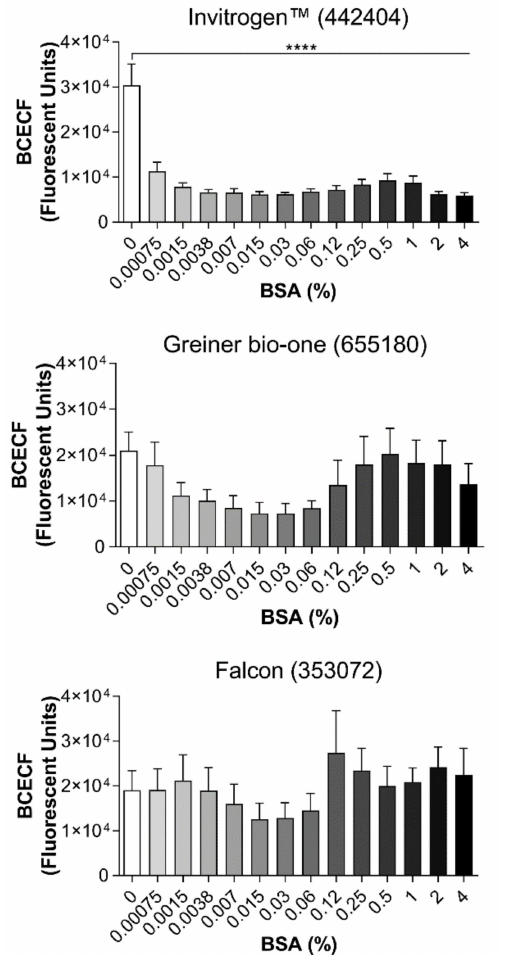
Figure 2. BSA blocking on di ff erent types of 96-well plates. BSA was used to prevent non-specific adhesion of platelets to the plastic. To find the optimum conditions, 3 types of 96-well plates (Invitrogen ™ —442404; Greiner Bio-one—655,180 and Falcon—353072) were blocked with di ff erent concentrations of BSA (0.00075 to 4% in 50 µ L) for 1 hour at 37 ◦ C. Next, human washed